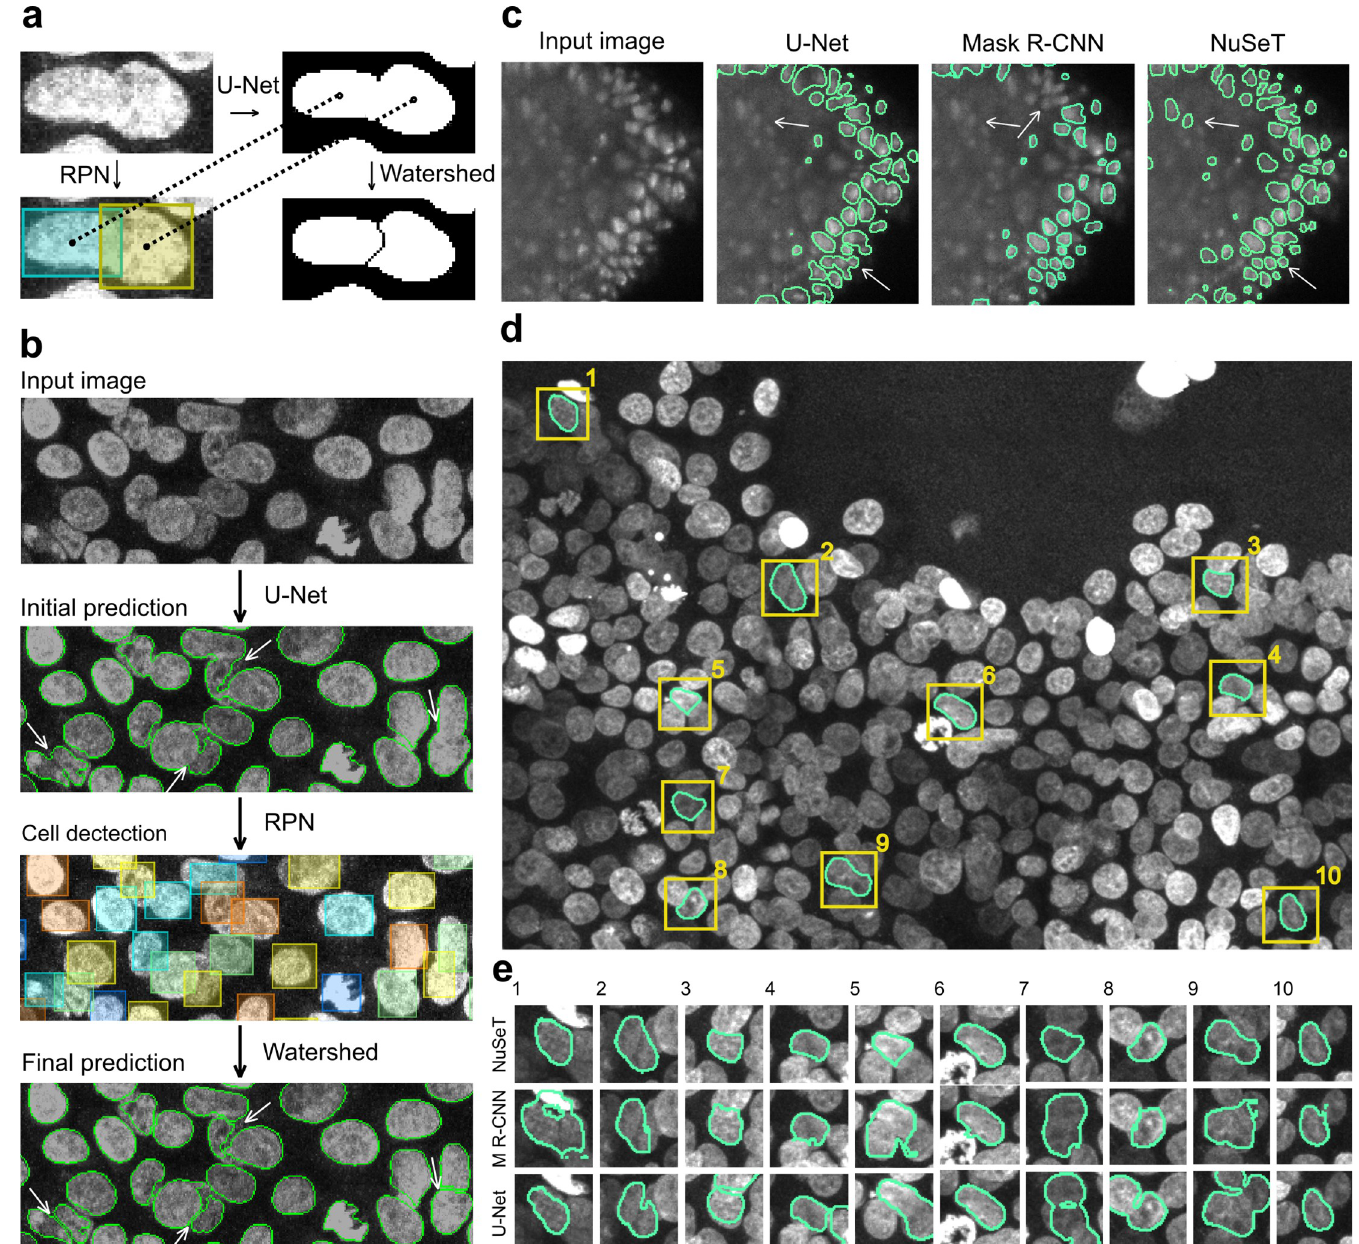
Fig 3. NuSeT efficiently addresses common segmentation challenges. (A) Implementing RPN-aided watershed algorithm improves touching cell separation. Bounding boxes and segmentation masks are computed by RPN and U-Net. Then the estimated centroid of each cell is computed from the coordinates of the bounding box. The watershed line is then estimated based on the binary mask and centroids. (B) Sample results showing that RPN successfully detects most of the cells, and watershed lines further separate touching cells. (C) Representative examples showing NuSeT detected more nuclei and better separated touching nuclei compared to Mask R-CNN and U-Net. (D,E) Examples nuclear masks generated using NuSeT for an image with high nuclei density (D). Comparison with the corresponding masks generated by Mask R-CNN and U-Net show subtle as well as prominent irregularities in boundary delineation that are circumvented by NuSeT (E). acini (n = 8) at different stages of disorganization. U-Net, Otsu’s Method and Mask R-CNN all detected only a fraction of all the nuclei (Fig 4D) in a dense acinus. The distribution of areas of segmented nuclei (n = 1365 nuclei) across multiple acini (n = 8) at first 5 time points shows